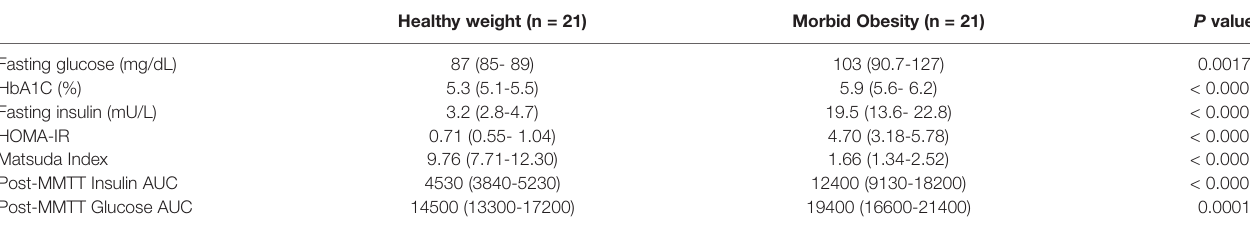
TABLE 3 | Mixed-meal tolerance testing, insulin resistance indices in participants with healthy weight and with morbid